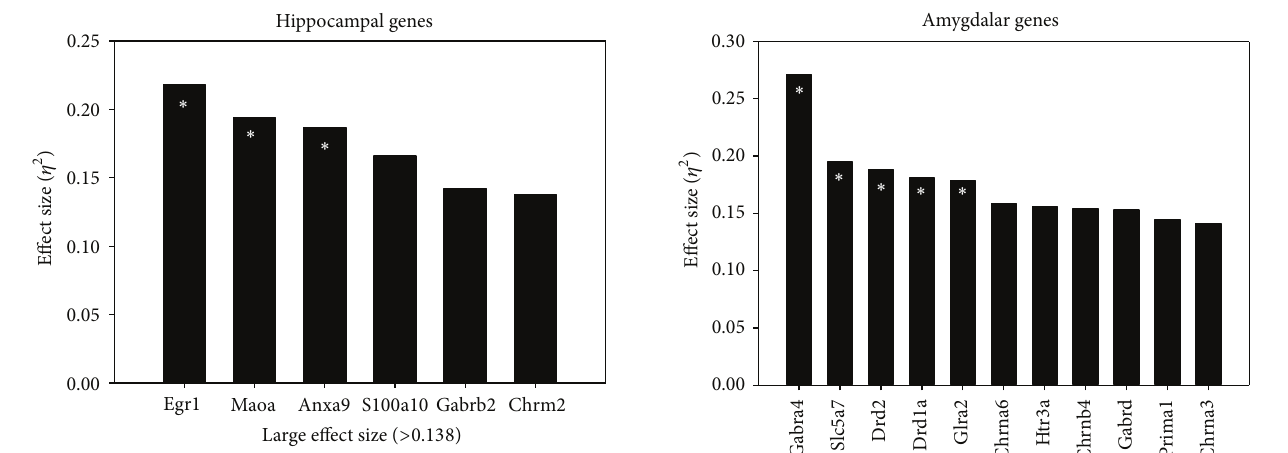
Figure 3: Effect size of gene changes in the hippocampus. Genes demonstrating a large effect size ( 𝜂 2 > .138 ) in the hippocampus as described in the Statistical Analysis. ∗ Significant 𝑃 value < .05. Figure 4: Effect size of gene changes in the amygdala. Genes demonstrating a large effect size ( 𝜂 2 > .138 ) in the amygdala as described in the Statistical Analysis. ∗ Significant 𝑃 value <